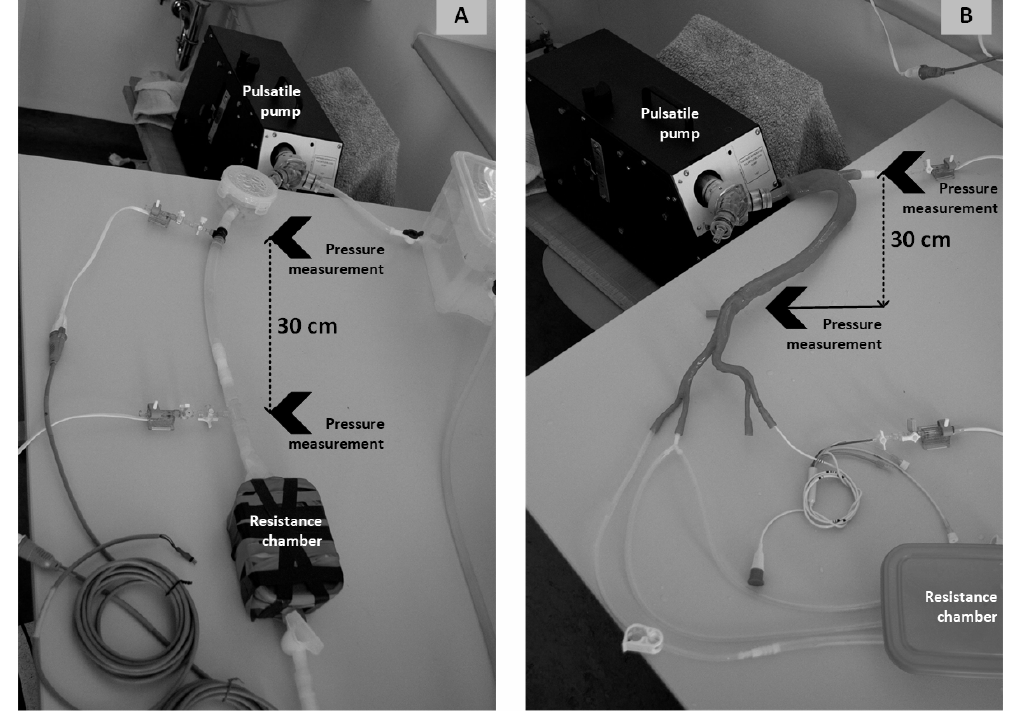
Figure 1. Experimental setting for development ( A ) and validation ( B ) of the computational